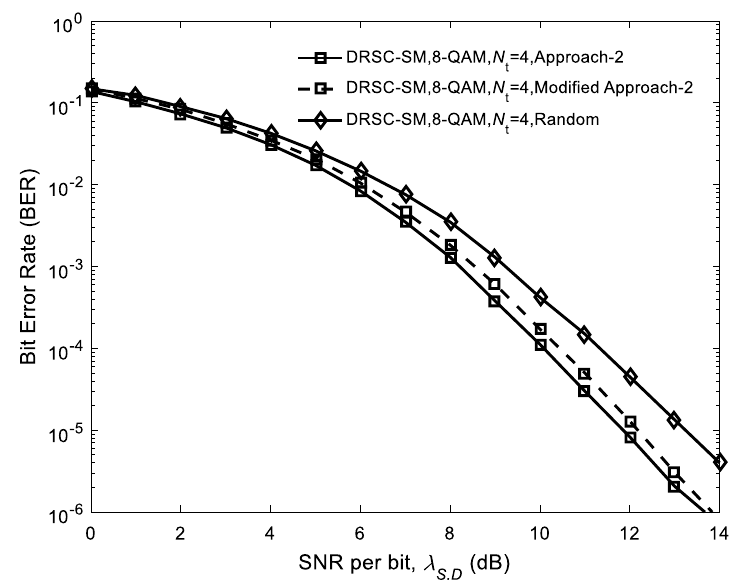
Fig. 7 Performance of DRSC-SM scheme (8-QAM) with RS 1 ( 31,25 ) and RS 2 ( 31,13 ) under different approaches. The solid line with diamond mark denotes the BER performance of DRSC-SM scheme under random approach. The solid line with square mark denotes the BER performance of DRSC-SM scheme under Approach 2. The dashed line with square mark denotes the BER performance of DRSC-SM scheme under modified Approach 2